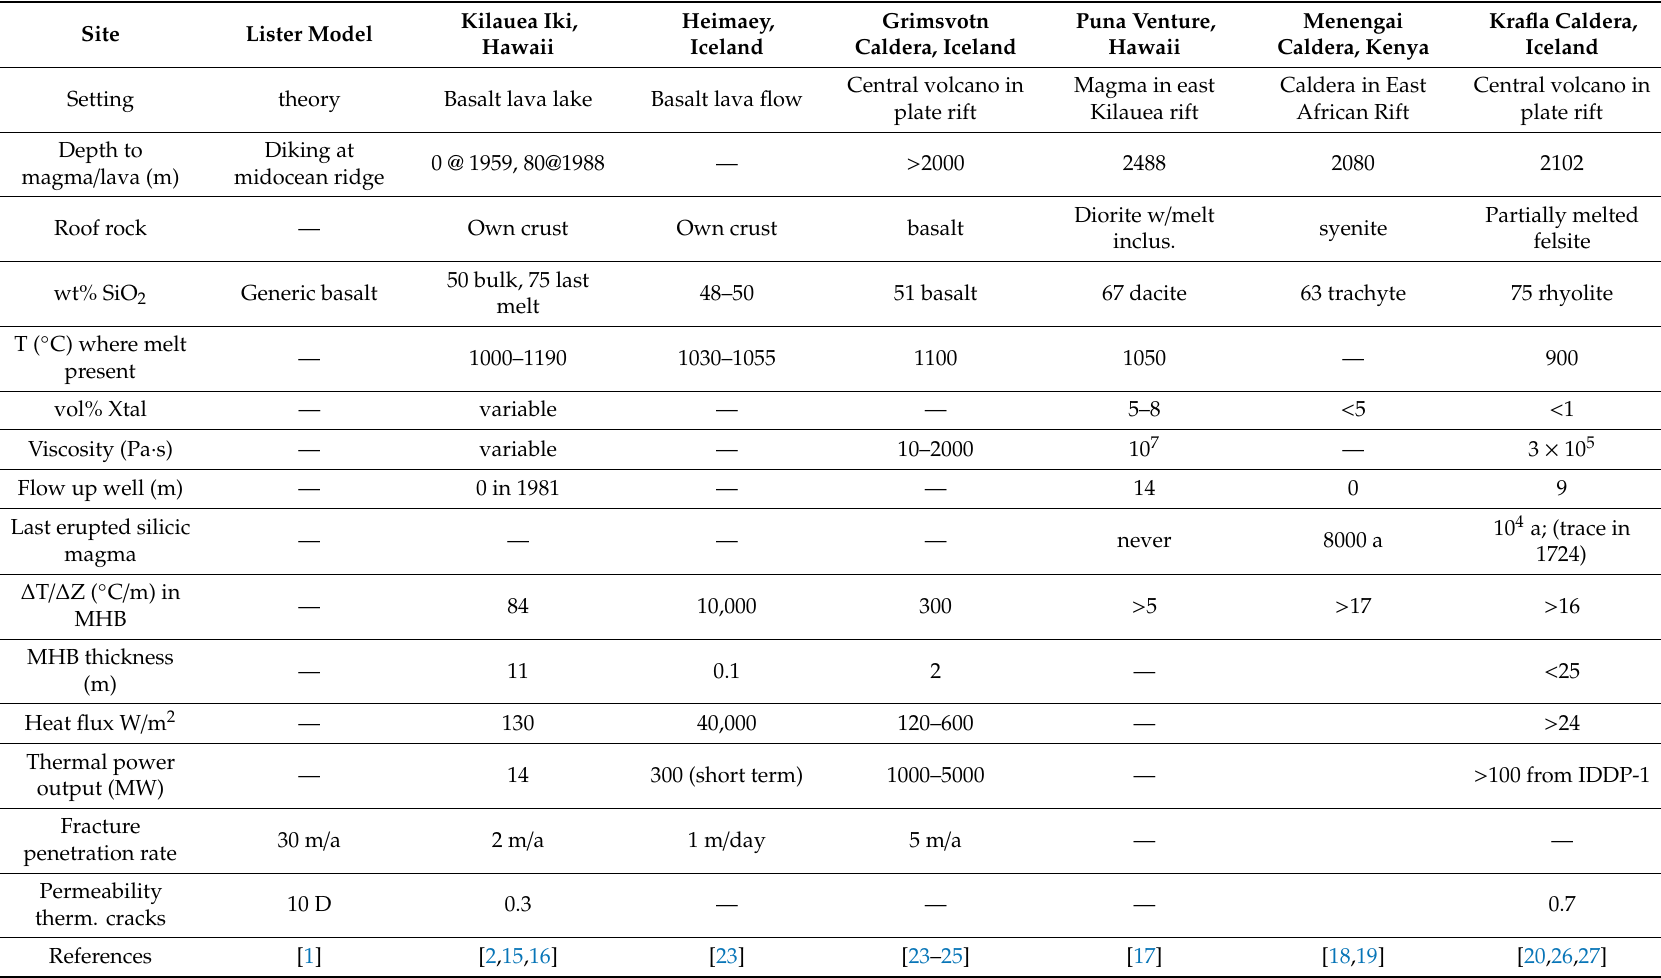
Table 1. Some modeling and drilling results pertaining to magma–hydrothermal